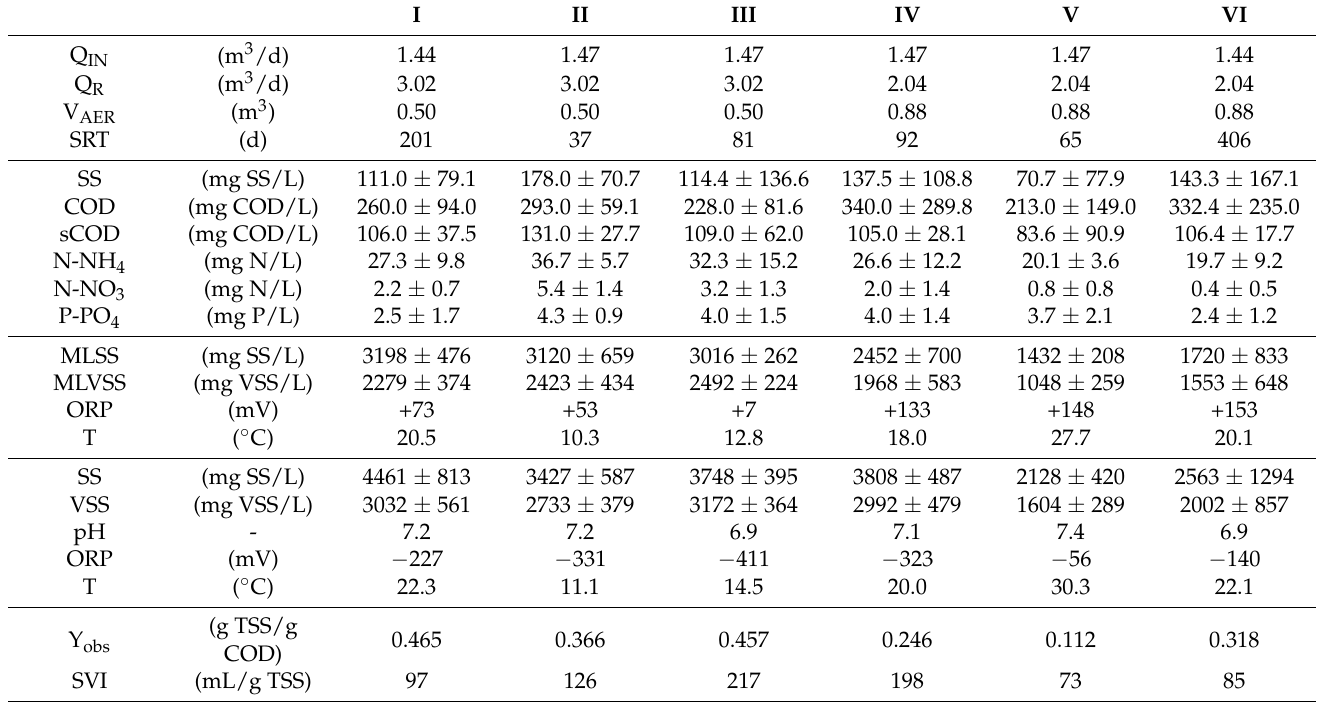
Table 1. Significant characteristics of the six periods of operation (extracted from